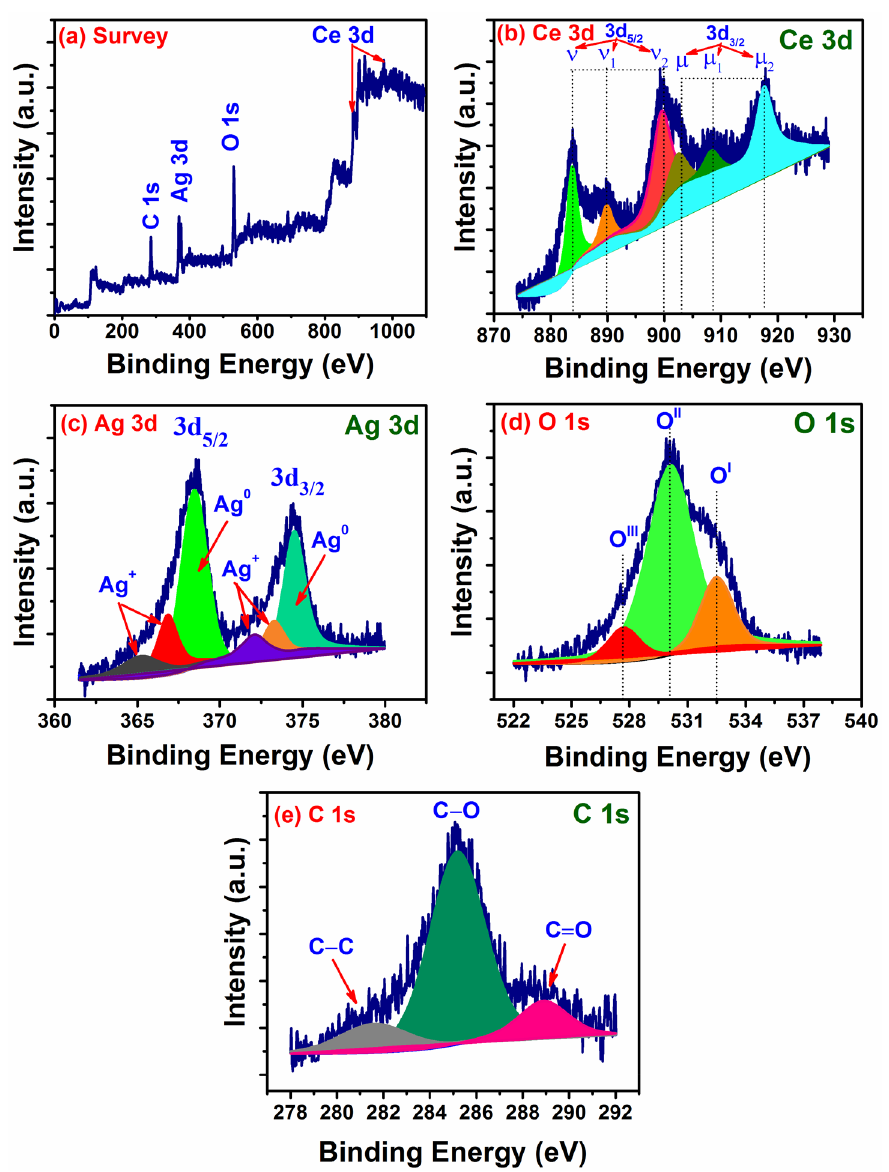
Figure 5. XPS survey and high-resolution spectra of Ag doped CeO 2 nanoparticles. ( a ) Survey, ( b ) Ce 3d, ( c ) Ag 3d, ( d ) O 1 s and ( e ) C